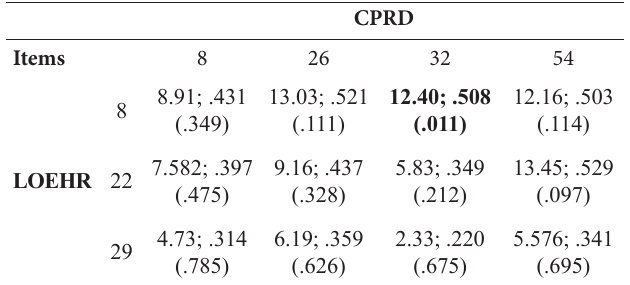
Table 3. Correlation of CPRD and LOEHR items on the variable self-confidence.